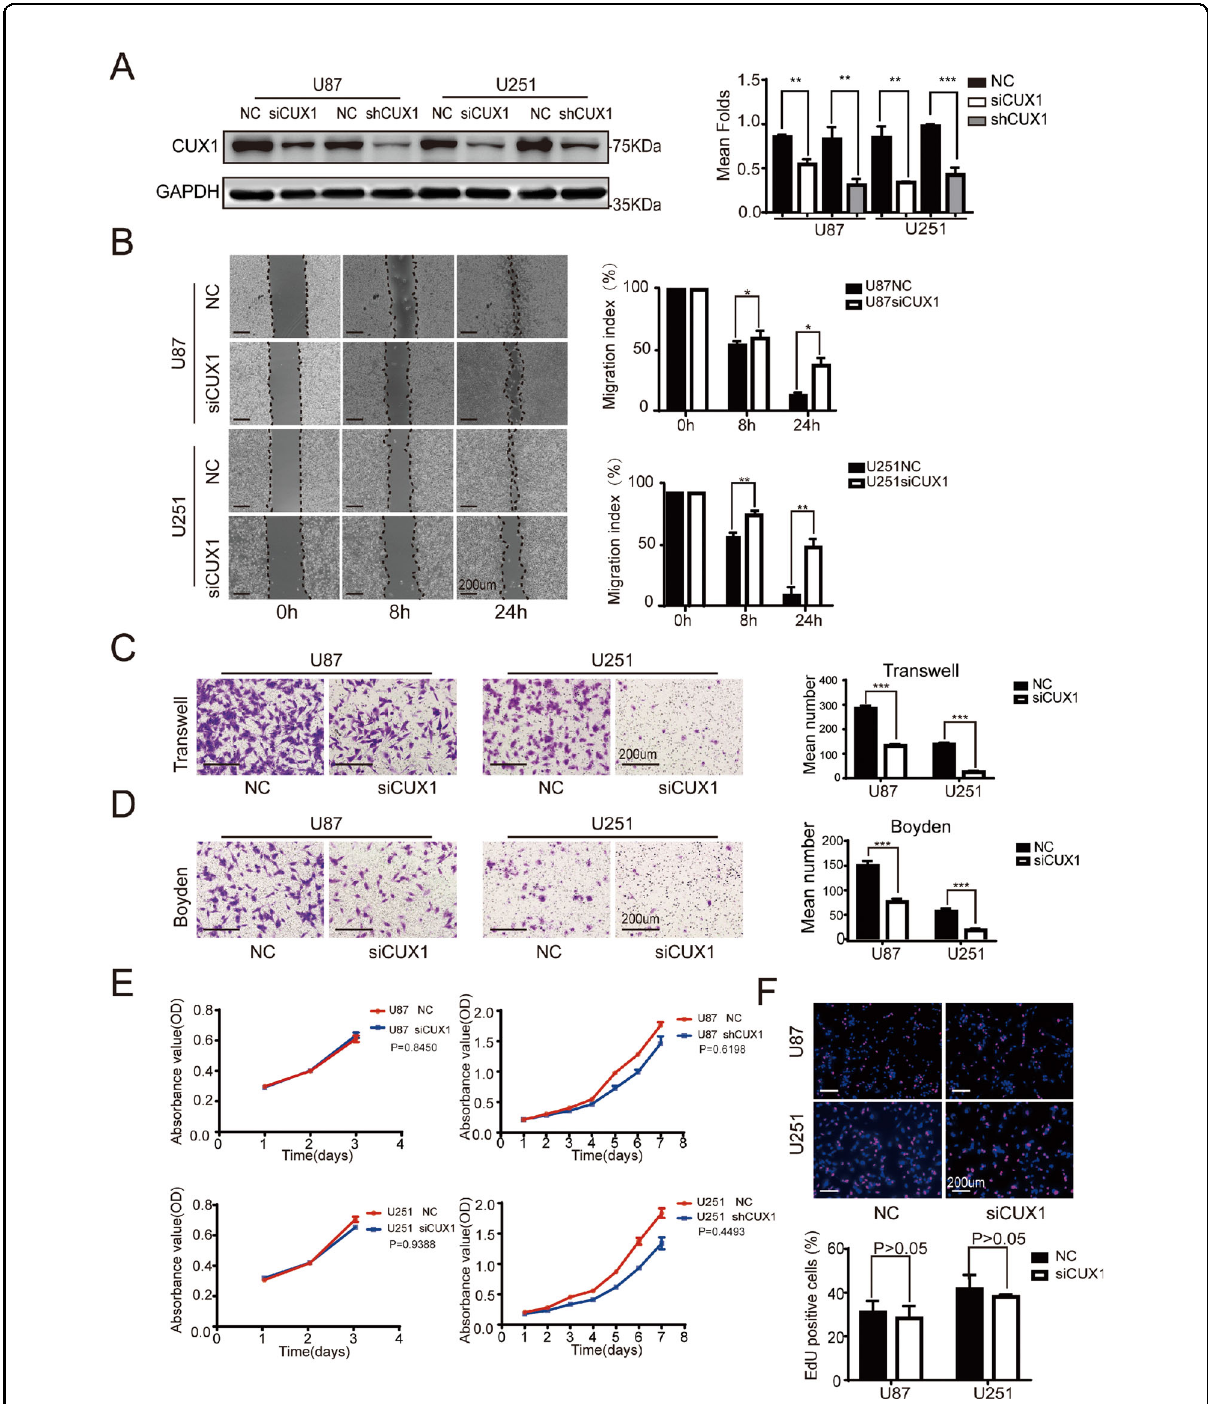
Fig. 2 CUX1 knockdown inhibited cell migration and invasion but not cell proliferation in vitro. a siRNA and shRNA against CUX1 decreased the expression of P75CUX1 in U87 and U251 cells compared with control cells by WB assay (**: P < 0.01; ***: P < 0.001). b Wound-healing assays indicated the siCUX1 transfection impaired cell migratory capacity, compared with the NC group (* P < 0.05; ** P < 0.01). c Transwell chamber assays revealed that CUX1 knockdown with siRNA transfection reduced the migratory capability of U87 and U251 cells (*** P < 0.001). d Boyden chamber assays showed that CUX1 knockdown with siRNA transfection reduced the invasive ability of U87 and U251 cells (*** P < 0.001). e CCK8 assays measured the modest effect on the proliferation of U87 and U251 cells following downregulation of CUX1 expression. f EDU incorporation assays revealed that the percentage of cells in the S phase had no statistical signi fi cance following downregulation of CUX1 ( P >